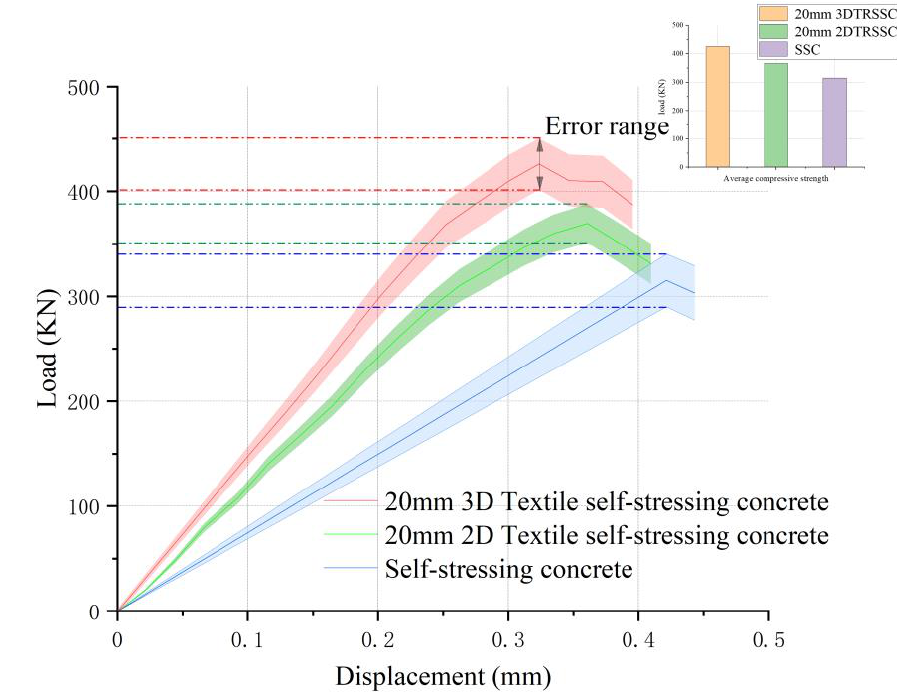
Figure 3. Load–displacement curve of compression Figure 3. Load – displacement curve of compression test.